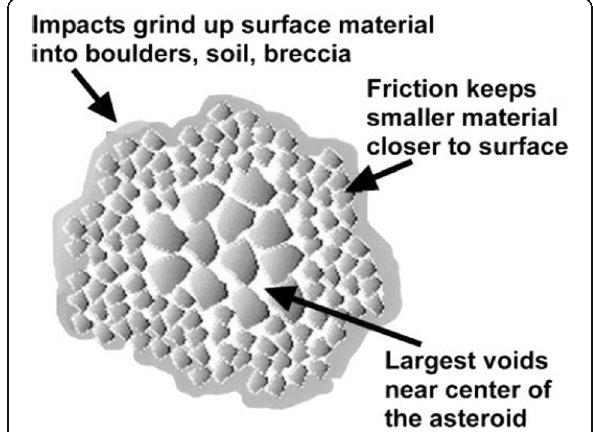
Fig. 13 Schematic of the possible structure of rubble pile asteroids. The original reaccretion of these objects is assumed to be particle size sorted with the largest pieces accreting first to form the core of the object and successively smaller sizes accreting later (Michel and Richardson 2013). The finest size fractions are generated at the surface by regolith action. These fine particles are confined to the near-surface zone by the dominance of frictional forces (from Britt and Consolmagno